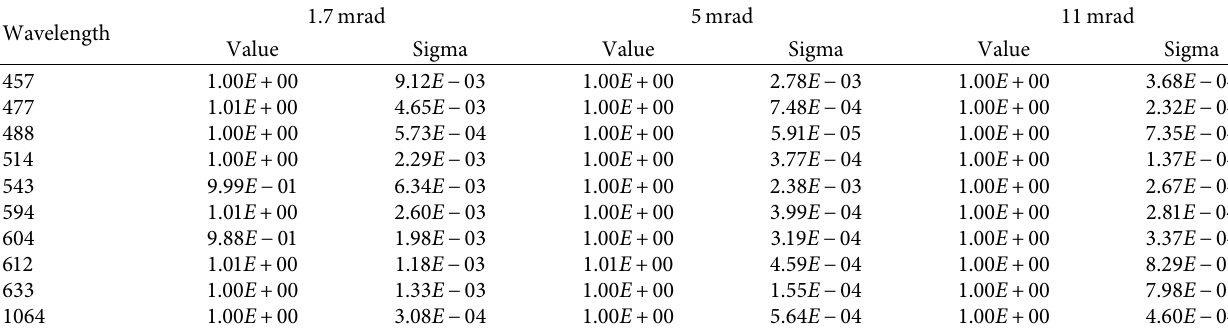
Table 3: Monochromator bandwidth correction factor for all mrad FOV values.